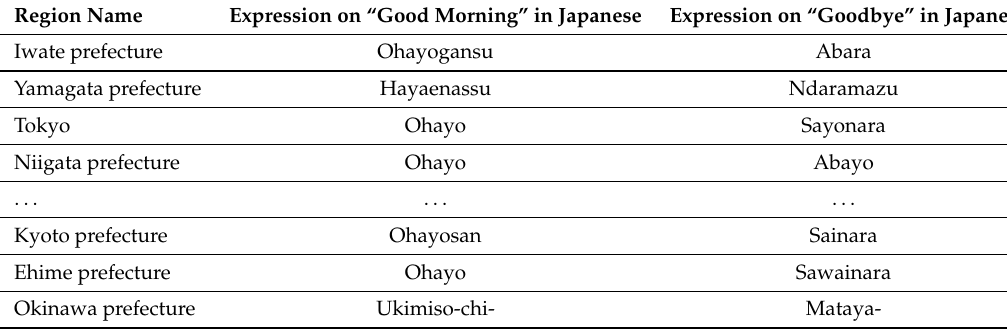
Table 4. Pronunciation of greetings in Japanese for persona.